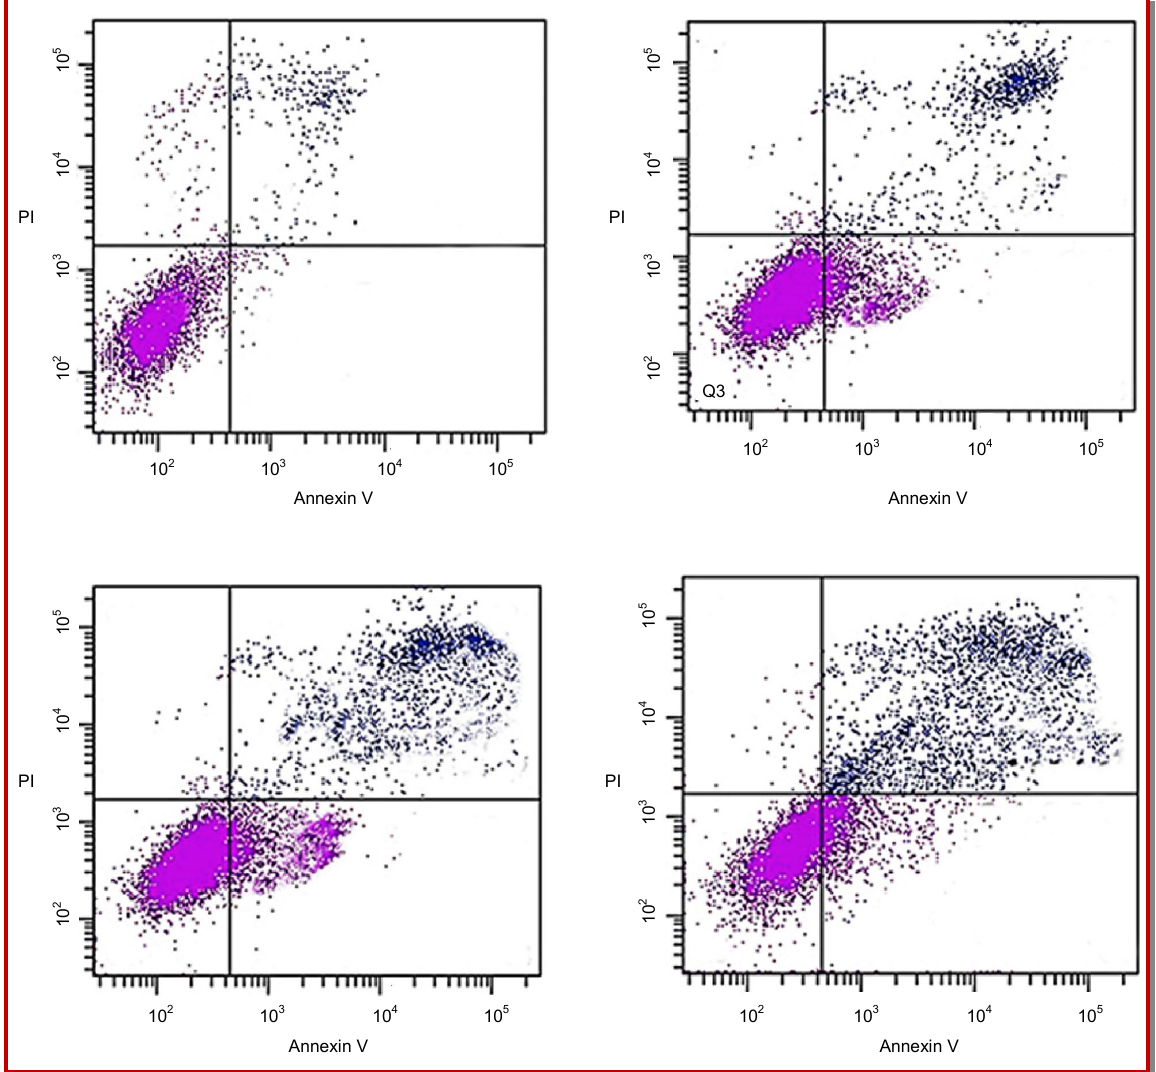
Figure 2: Evaluation of apoptosis by annexin V-FITC assay in human cervical cancer cells (HeLa) induced by iridomyrmecin. After the cells were treated with 0, 10, 20 and 80 µM dose of iridomyrmecin for 48 hours and then analyzed by flow cytometry. With increase in the dose of iridomyrmecin, there was a significant increase in the percentage of early and late apoptotic